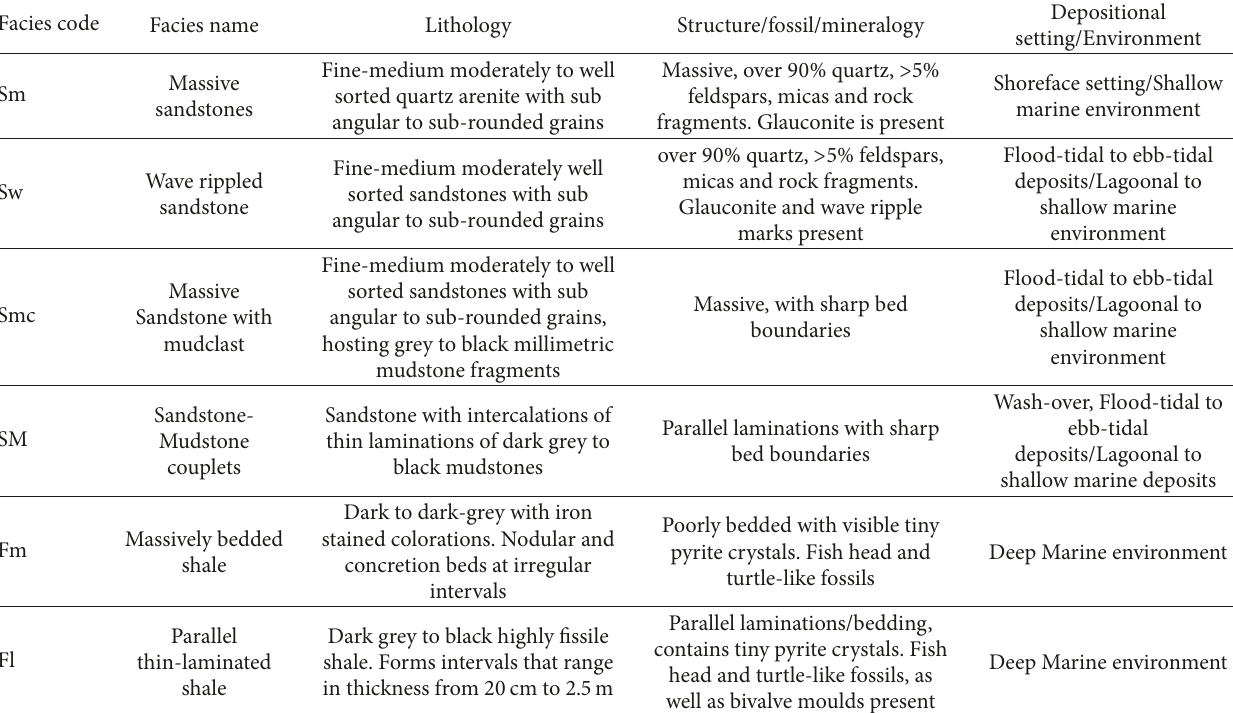
Table 1: Summary of the lithostratigraphic description and inferred depositional environment for sediments studied. Facies